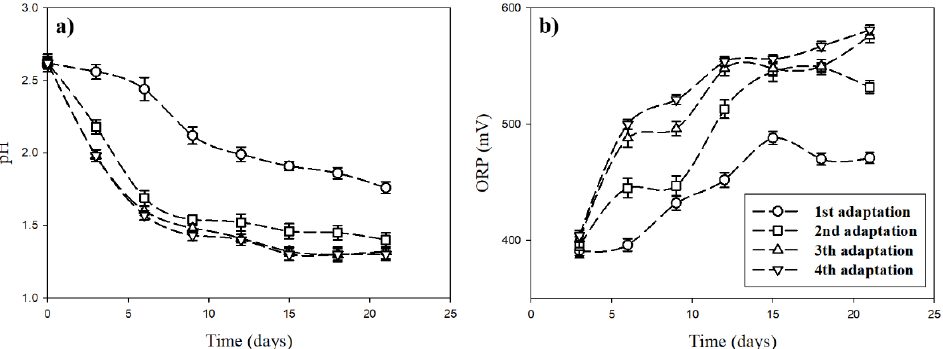
Figure 5. Variations of pH ( a ) and oxidation/reduction potential (ORP) ( b ) in the culture medium during different adaptation cycles.